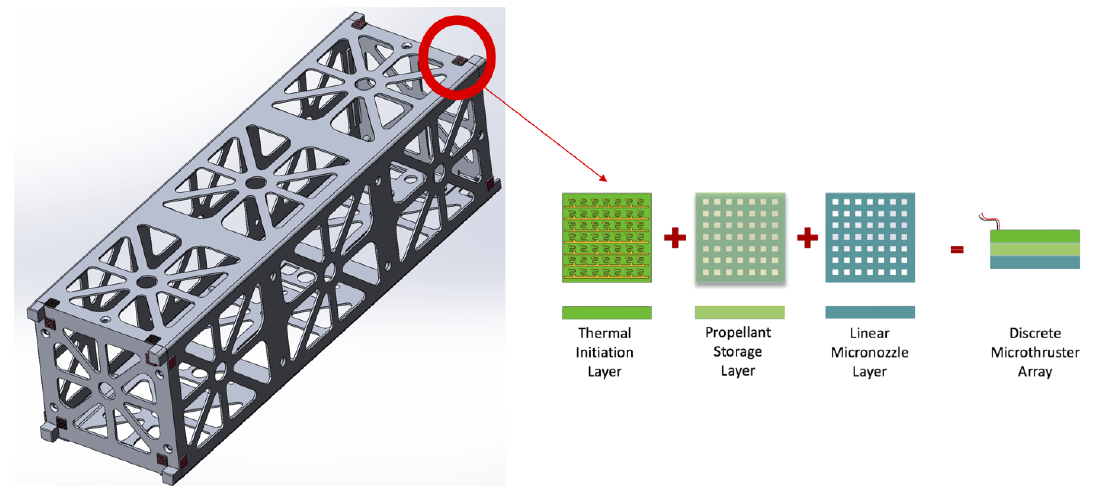
Figure 1. Schematic of the conceptual microthruster arrays mounted on a 3U cubesat. The cubesat dimensions are 10 × 10 × 30 cm and the envisioned size of the discrete microthruster array is less than 1